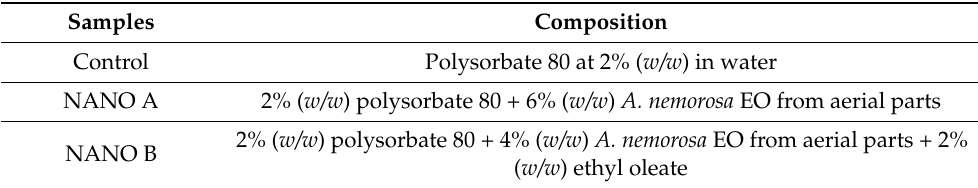
Table 4. Composition of the formulated A. Nemorosa EO-based nanoemulsions (NANO A and NANO B) and